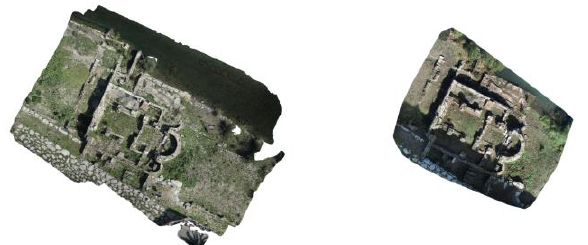
Figure 5. Ortophotos, taken in 2014 and 2016, give insight on heritage